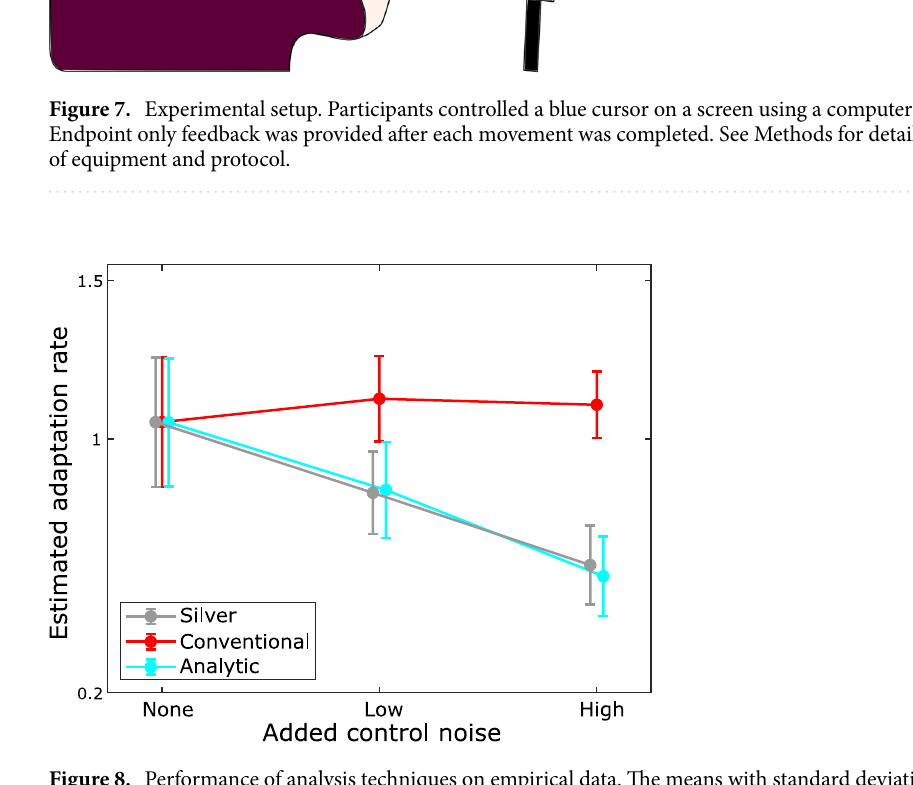
Figure 8. Performance of analysis techniques on empirical data. The means with standard deviation error bars comparing the three analysis methods run on data collected from 26 able-bodied participants completing a computer cursor movement study under different added noise conditions. Note that the silver adaptation rate and conventional estimate are equivalent with no added control noise. All pairwise differences within silver ARs and analytic ARs are statistically significant (ANOVA with Bonferroni-corrected post-hoc comparison, p <